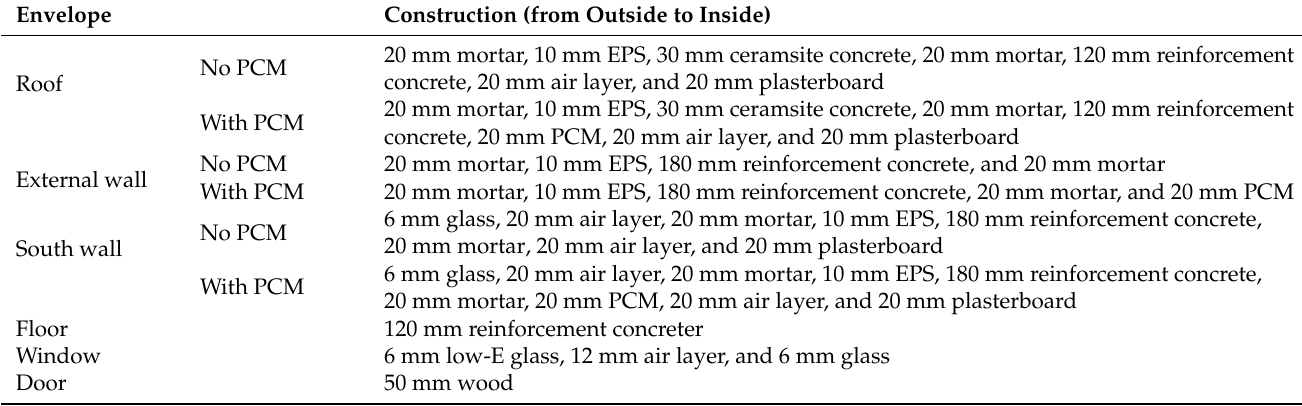
Figure 1. ( a ) Schematic of the model room; ( b ) schematic of the roof; ( c ) schematic of the south wall: (1) plasterboard; (2) PCM panel; (3) construction material; (4) solar absorbing coating. Table 1. Details of the rooms. Table 2. Thermophysical properties of the building materials.